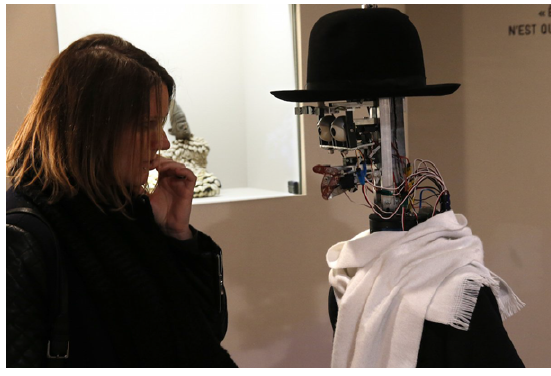
Figure 1: The robot ”Berenson” in Quai Branly Museum during PER- SONA exposition. Berenson generalises its learning on the visitors faces. Here, the visitor and the robot observe each